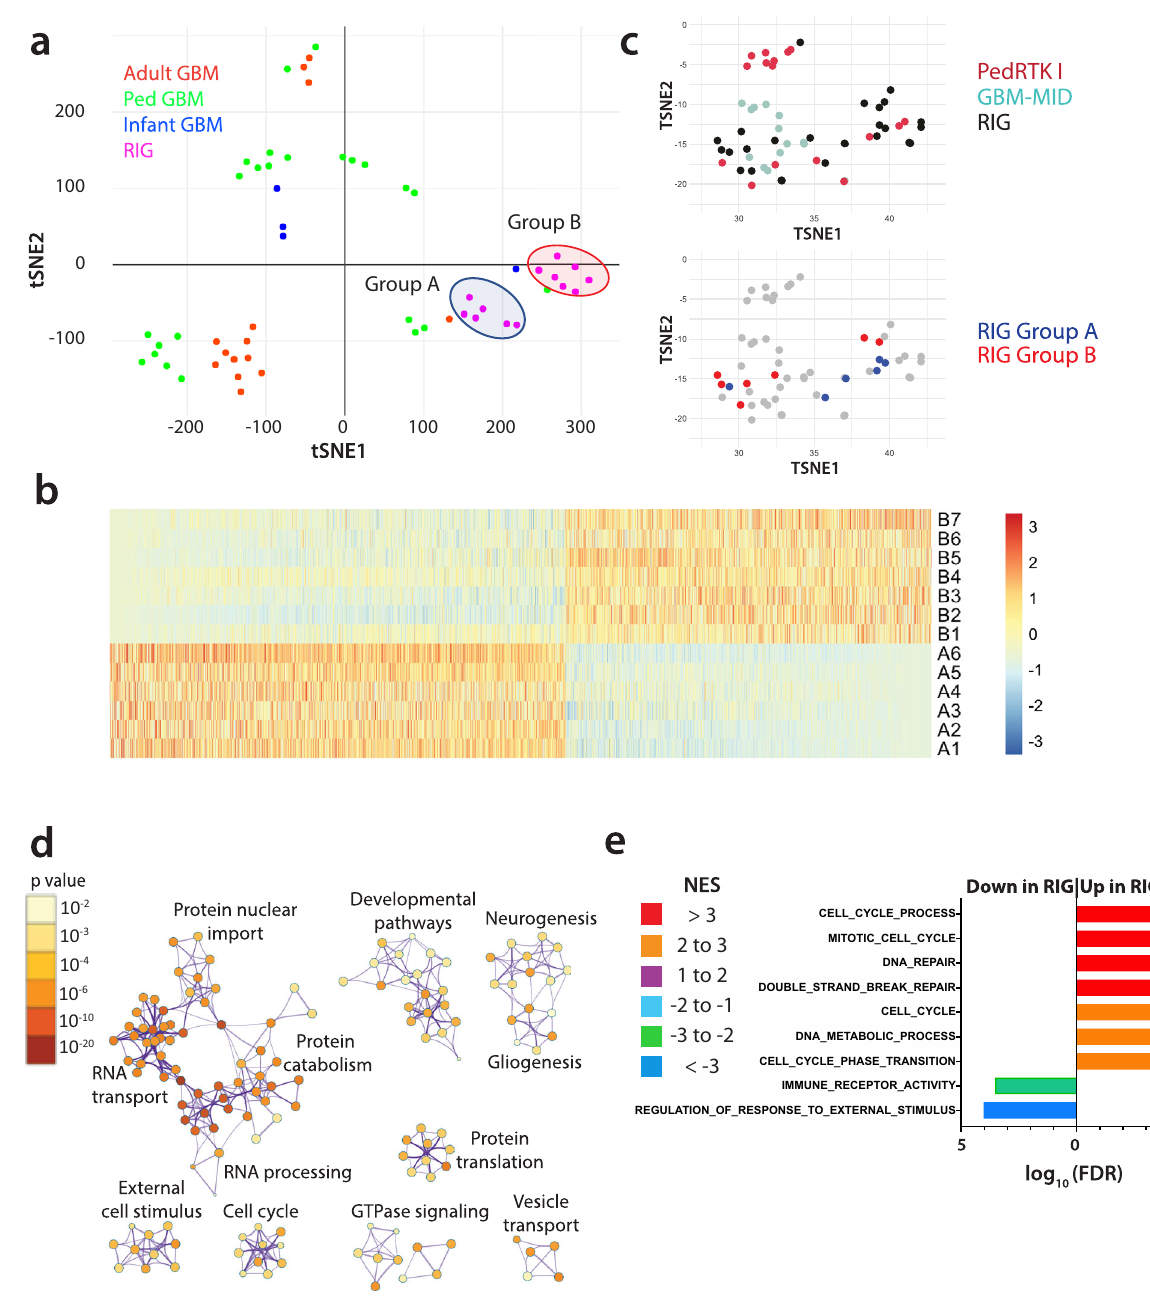
Fig. 5 Gene expression pro fi ling of RIG versus de novo GBM. a Clustering of RIGs with microarray-based transcriptomic data ( n = 13) versus de novo pediatric GBM ( n = 24), infant GBM ( n = 4), and adult GBM ( n = 14) using t-SNE analysis. b Heatmap of genes whose mean expression differs between RIG Groups A and B ( n = 2961, P < 0.05) (Labels A1 – A6 represent subgroup A RIG tumors and B1 – B7 represent subgroup B tumors). The scale represents fold change of Group A vs. Group B. c Upper panel: methylation clustering showing locations of RIGs versus PedRTK I and GBM reference clusters; Lower panel: methylation-based clustering of RIGs showing transcriptomic group A and group B locations. Despite overlap of a few samples, group A and group B clustered separately by methylation ( P < 0.05); d Metascape analysis based on GO genesets shows cellular pathways and processes that differ based on gene expression between RIG and de novo GBM (from panel A); color scale represents the P value; comparisons are non-directional between sample sets. e GSEA using GO genesets identi fi es differences in gene expression between RIG and de novo GBM (from panel A); number scale represents the log of the FDR (with FDR = 0 set to a value of 5 for purposes of plotting); colors represent the ratio of GSEA normalized enrichment score ( NES ) of RIG/de novo GBM. GO gene ontology, GSEA geneset enrichment analysis, RIG radiation-induced high-grade glioma, GBM glioblastoma, FDR false discovery In silico and in vitro drug screening . To identify potential Fig. 11A). Because most anticancer drugs inhibit their targets, the therapeutic susceptibilities in RIG, Metascape and GSEA were focus was on potential oncogenes and oncogenic pathways, that used to identify upregulated gene expression pathways in RIG is, genes with upregulated expression in the Metascape analysis versus normal pediatric cortical tissue (Fig. 7a and Supplementary and genesets with positive normalized enrichment scores ( NES )